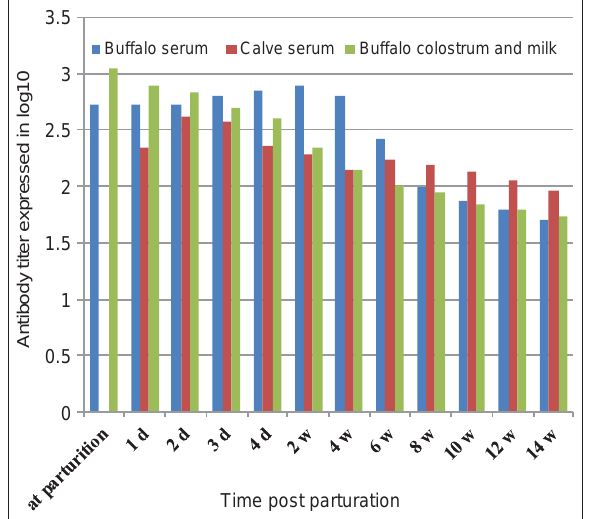
Figure 7: Comparison between the mean antibody titer of serum and colostrum of vaccinated buffalo, their calves by enzyme linked immunosrobent